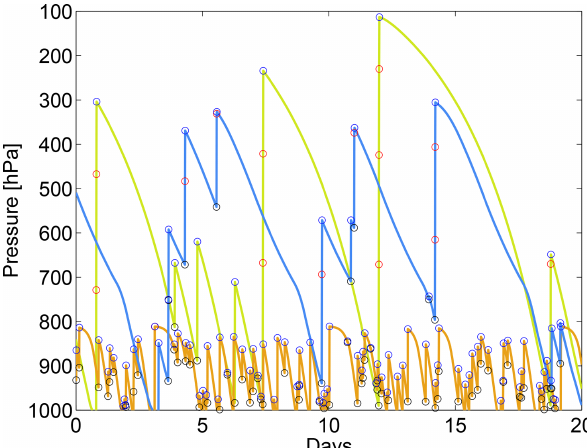
Figure 7. Example trajectories from the run with the idealized setup for forward trajectories with large-scale wind set to zero and con- stant convective area profile. Open black circles mark entrainment, open red circles upward transport in convection in 10min steps and open blue circles detrainment.